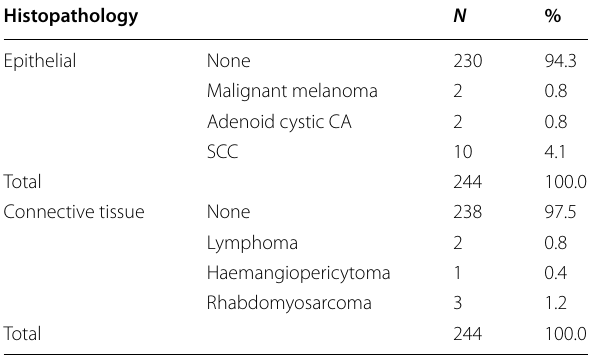
Table 4 Clinical diagnosis after histopathology: malignant neoplastic masses among patients with sinonasal masses in Khartoum ENT teaching hospital (study 2020–2021).